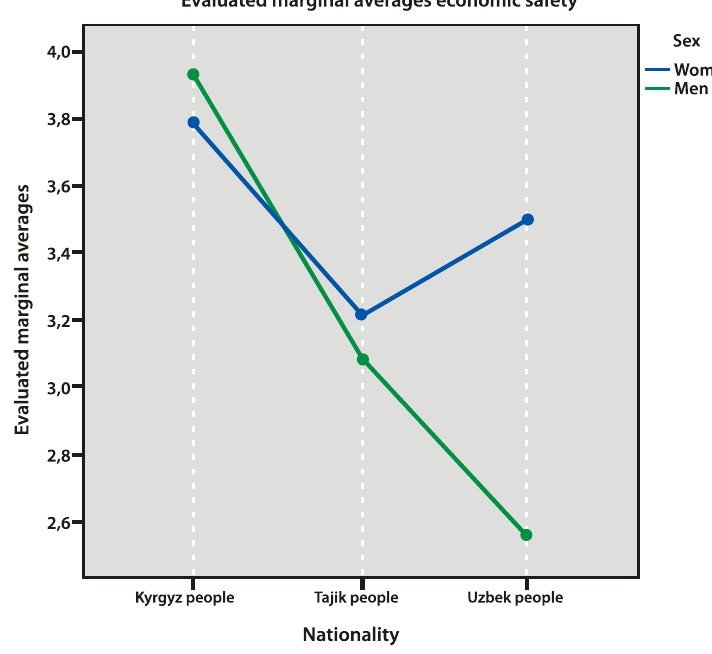
Figure 4. Economic safety factors.